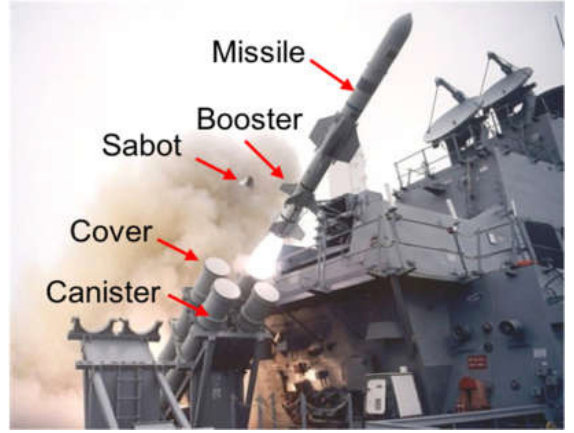
Figure 1. Overview of a similar canister for a Harpoon missile [4].